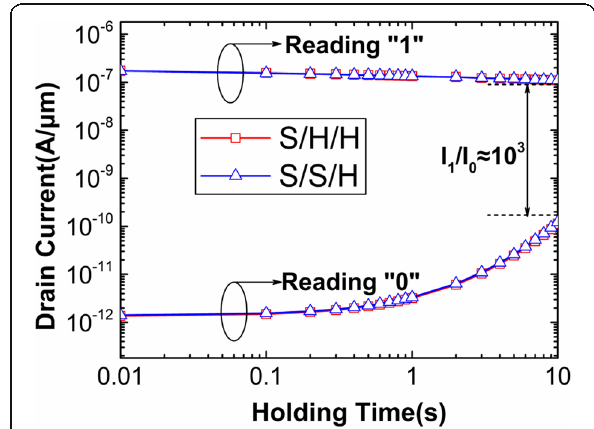
Table 4 extracts the performance properties of S/S/H with the decreasing of L three numbers of each abbreviation represent L and L . g2